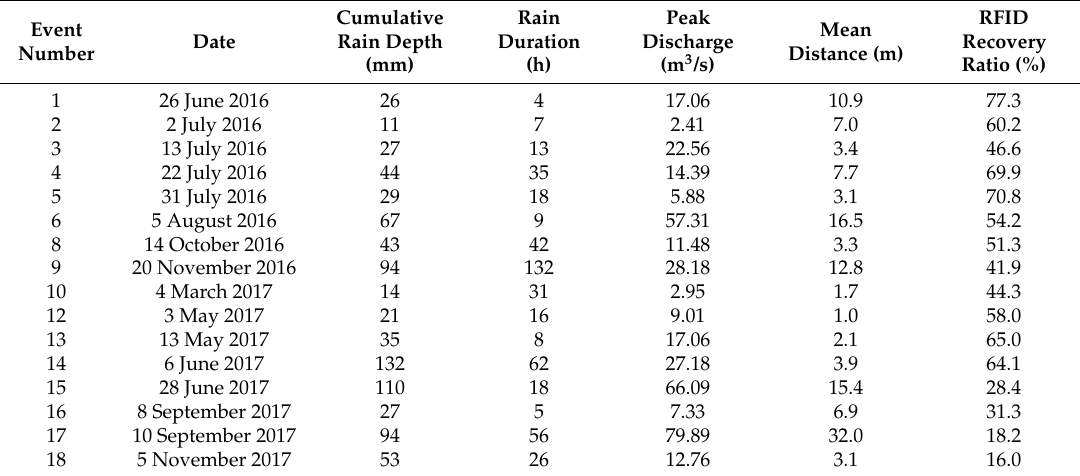
Figure 4. Deployment of the tracers and their position in the stream, reach 6 (modified after [55]). ( a – c ) Show three deployment spots in reality and on the ortophoto; ( d ) Is the ortophoto of reach 6 where yellow dots are tracer starting points, numbered from 1 to 4, red dots are painted bed patches, and red squares are the most active zones found with digital elevation model (DEM) comparison. Table 3. Main features of surveyed events. Peak discharge is measured at an outlet.